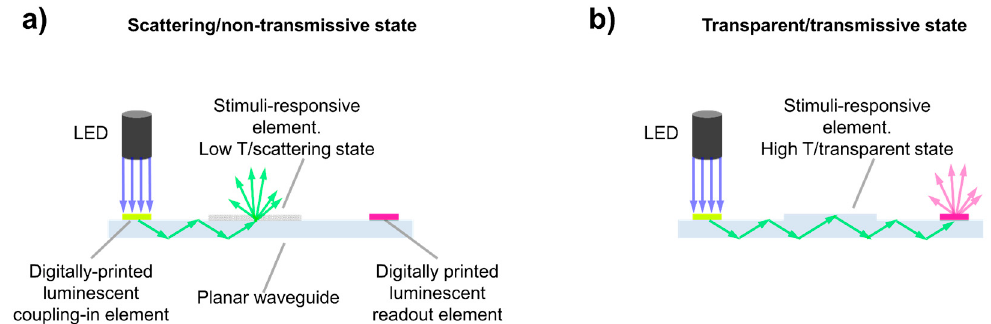
Figure 1. Optical planar waveguide sensor with integrated digitally-printed luminescent light coupling-in and readout elements. Remote excitation of the first luminescent element, by using an LED for example, enables coupling of light into the waveguide. Light is guided towards the thermoresponsive LCP element that regulates the light intensity transmitted towards the end of the waveguide where the second luminescent element is placed. ( a ) Scattering/non-transmissive state, at low temperature: light is scattered out of the waveguide at the stimuli-responsive element. ( b ) Transparent/transmissive state, at high temperature: light is not scattered at the stimuli-responsive element, and therefore, light further propagates in the waveguide and reaches the second luminescent layer. Remote luminescence intensity measurements allow quantifying the temperature in the sensor range.